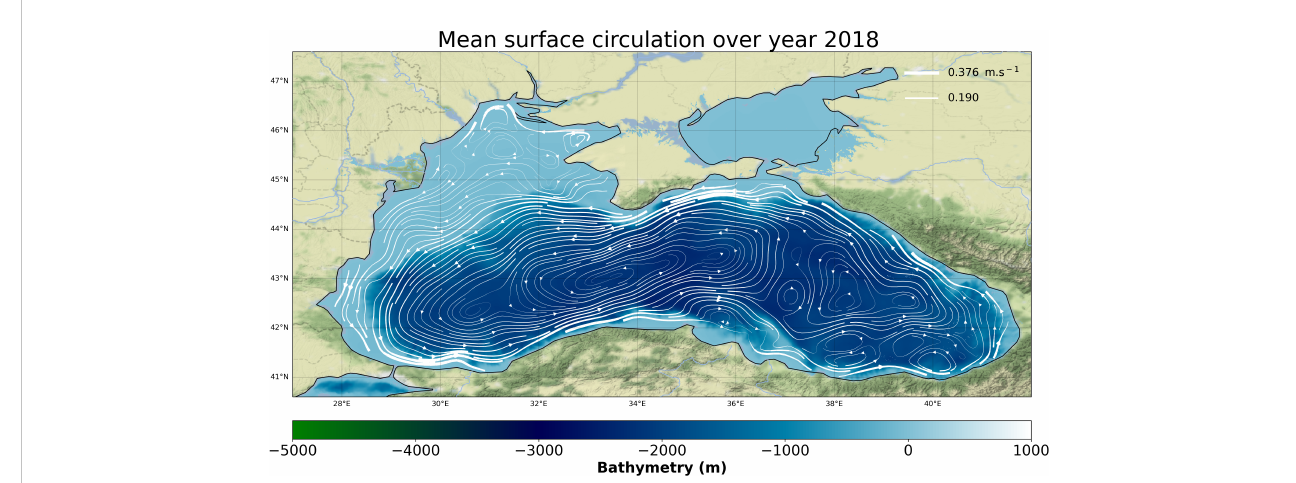
FIGURE 1 The Black Sea annual averaged circulation (for 2018) obtained with EO4SIBS altimetry